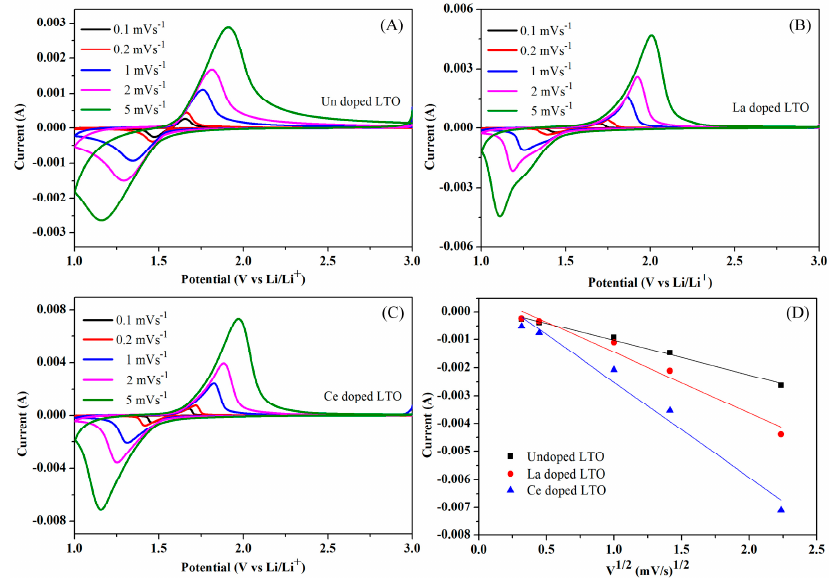
Figure 6. Cyclic voltammetry (CV) curves of undoped LTO ( A ); La-doped LTO ( B ); Ce-doped LTO ( C ); at varied scanning rates from 0.1 to 5.0 mV/s; The cathodic peak currents against square roots of scan rate ( D ).